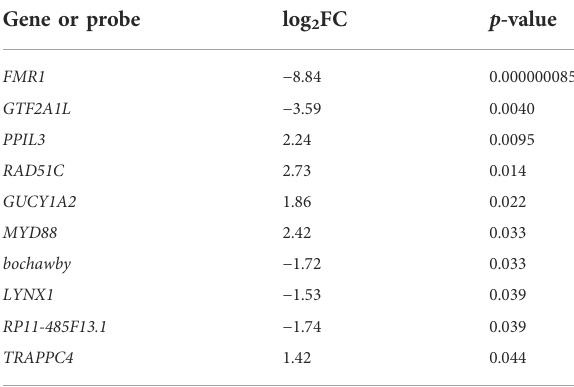
TABLE 1 Differently expressed genes between human iPSC-derived FXS and control D7 NPCs. p -values have been adjusted by the method of Benjamini and Hochberg (Benjamini and Hochberg,